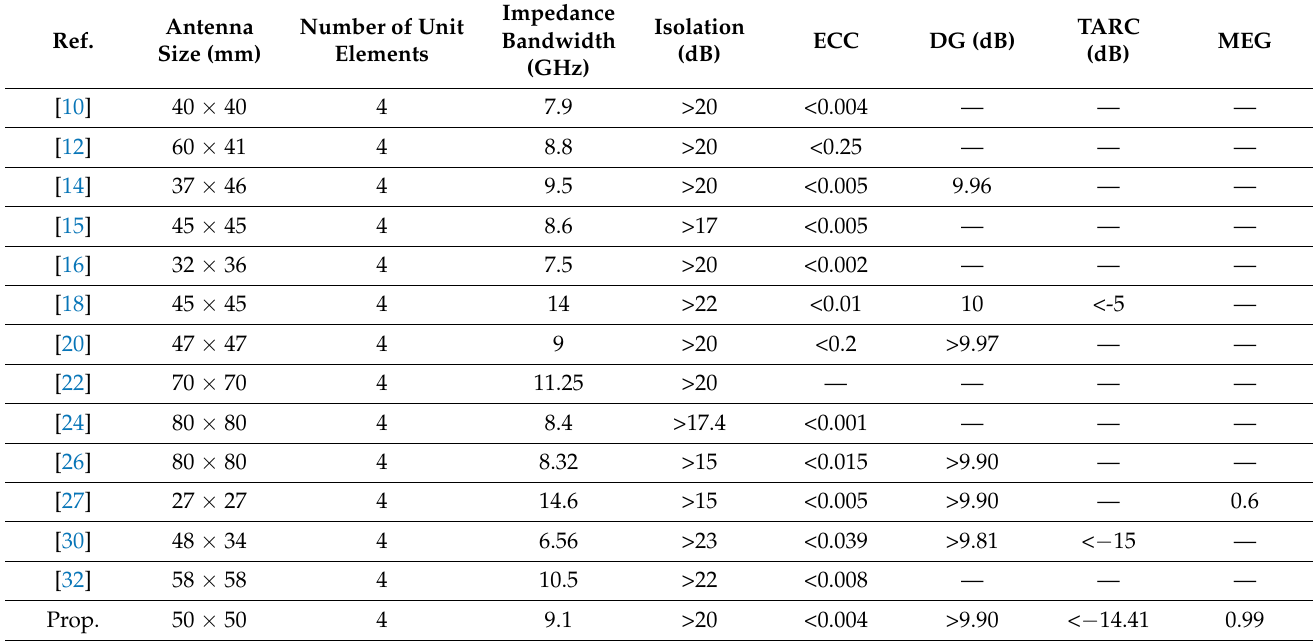
Table 2. Comparison of the proposed antenna and the antenna reported in the literature.